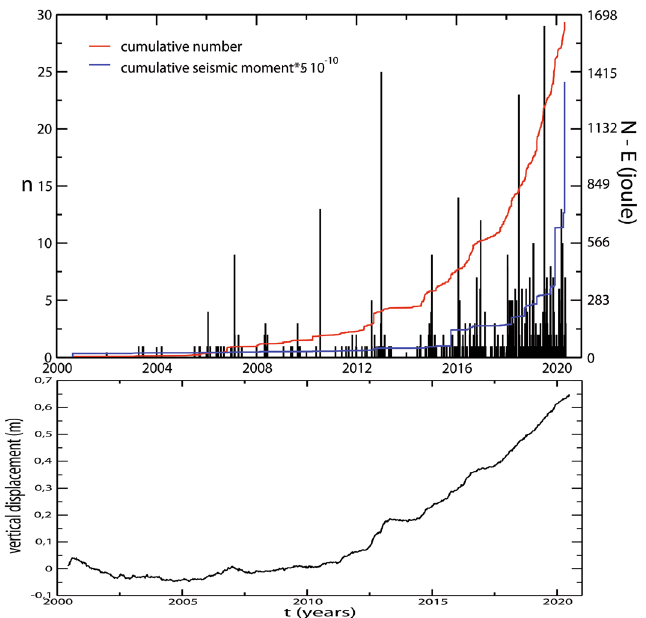
Figure 1. Top panel: histogram of the earthquakes with Mc ≥ 0.2 per day (black); cumulative of the earthquakes number (red) and cumulative of the energy released (blue) of the whole catalogue. Bottom panel: Vertical daily displacement at RITE (Rione Terra, Pozzuoli) GPS station from 29 May 2020 to 30 June 2020.